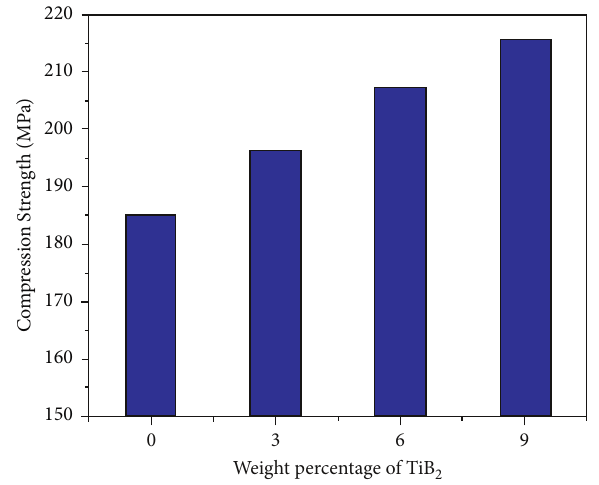
Figure 8: Influence of compression strength on the wt% of TiB